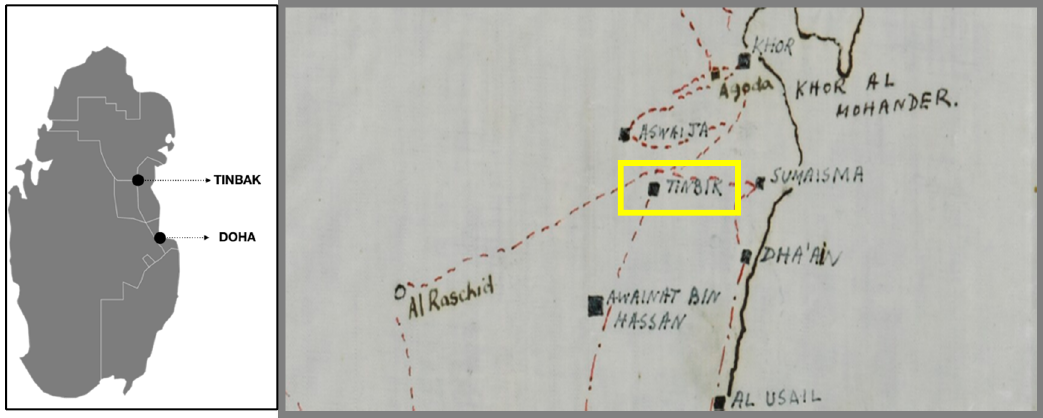
Figure 2. A map of Tinbak in 1937. It stands as an important town. Red dashed lines refer to the routes traversed by foot among different settlements. (Right: Qatar National Digital Library, 2020; left: MME, edited by the Authors).